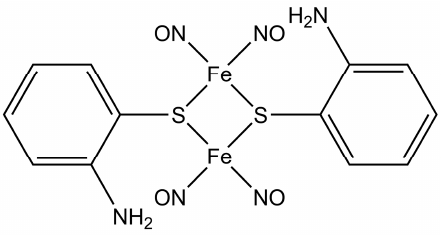
Figure 1. Structure of 2-AmPh .